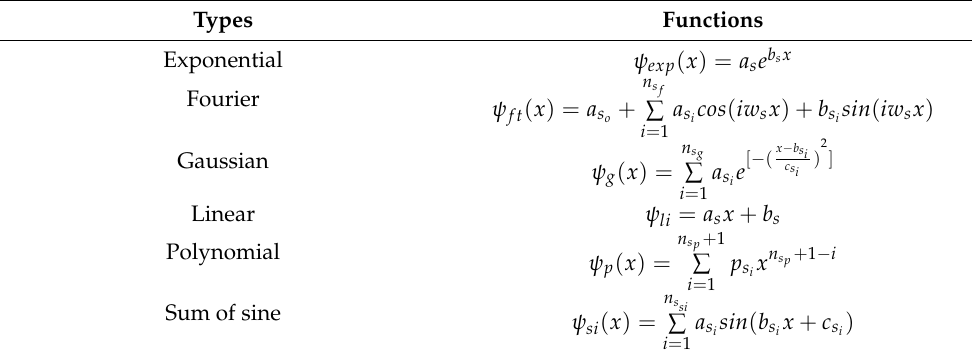
Table 2. Curve-fitting functions of the